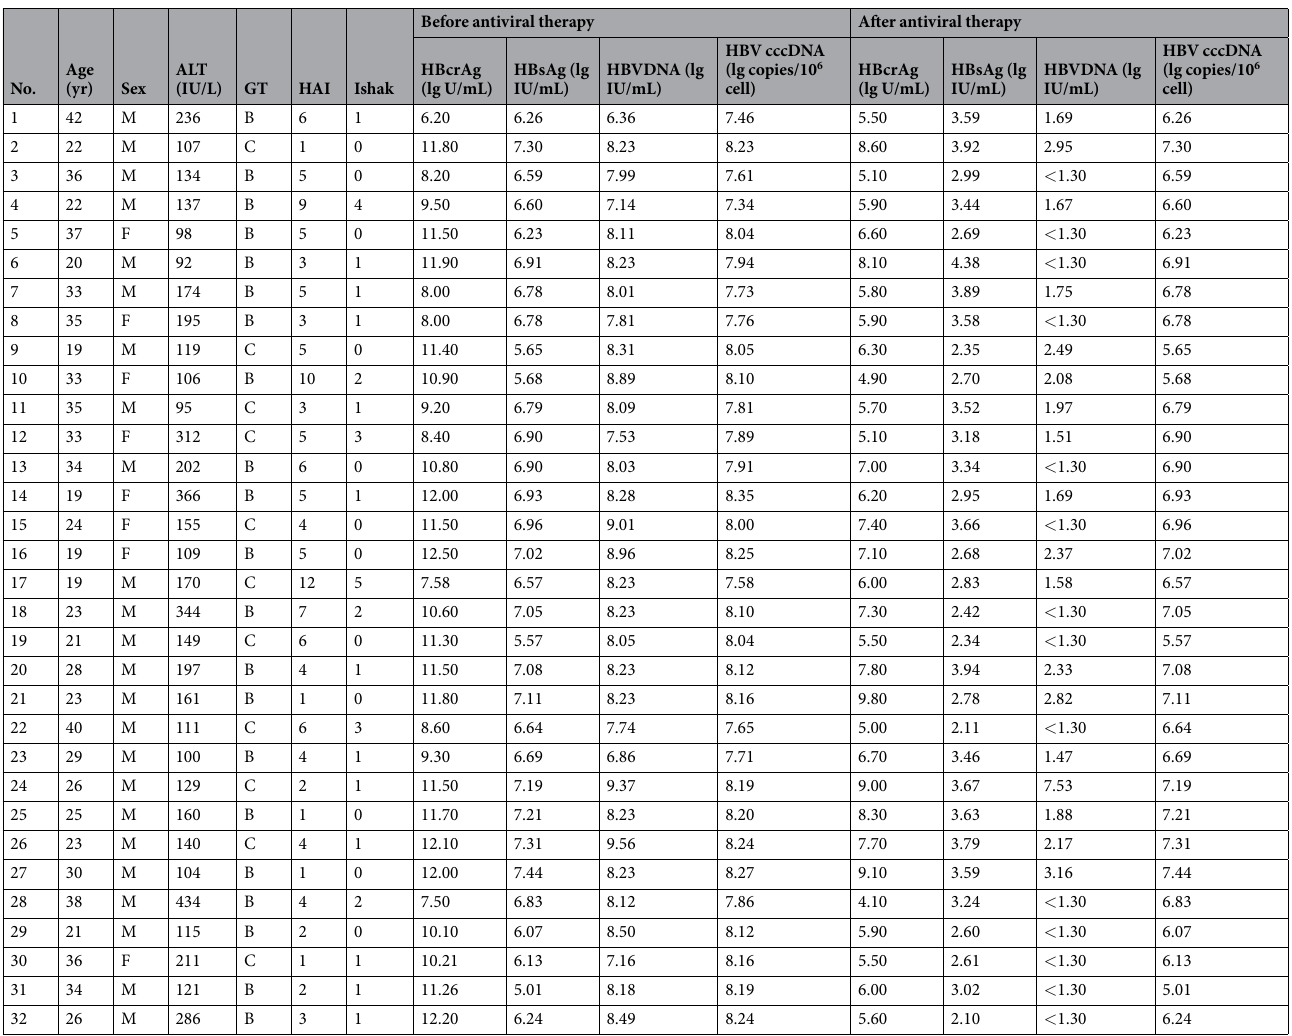
Table 3. The detailed information of patients receiving entecavir treatment in IC phase of